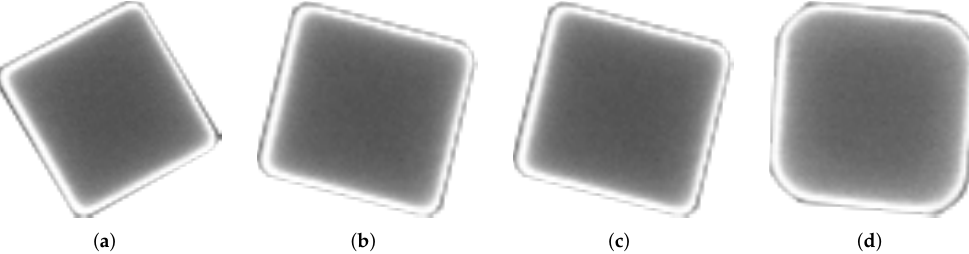
Figure 1. Manually segmented images of Ag nanocubes used as template to generate new images. These four templates, taken from the micrograph in Figure 2, constitute the second pattern used in this work: ( a ) Template #1 of an Ag nanocube; ( b ) Template #2 of an Ag nanocube; ( c ) Template #3 of an Ag nanocube; and ( d ) Template #4 of an Ag